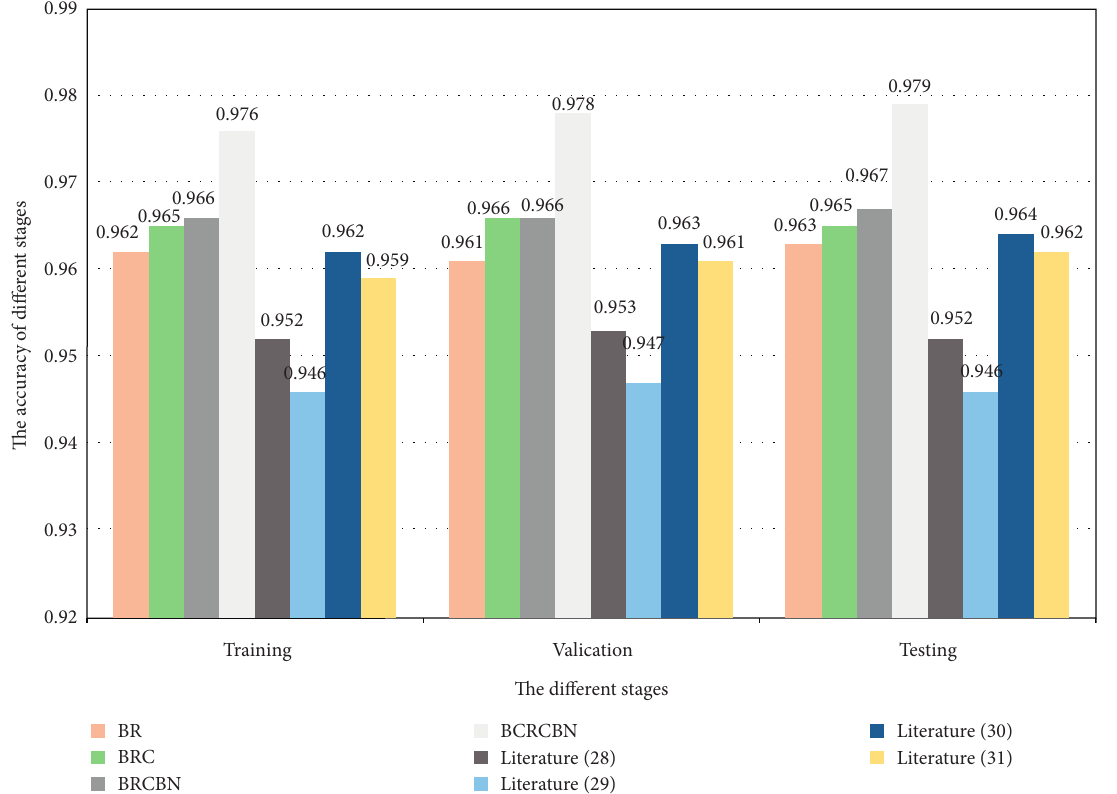
Figure 5: The accuracy of part-of-speech tagging in WSJ corpus for different network